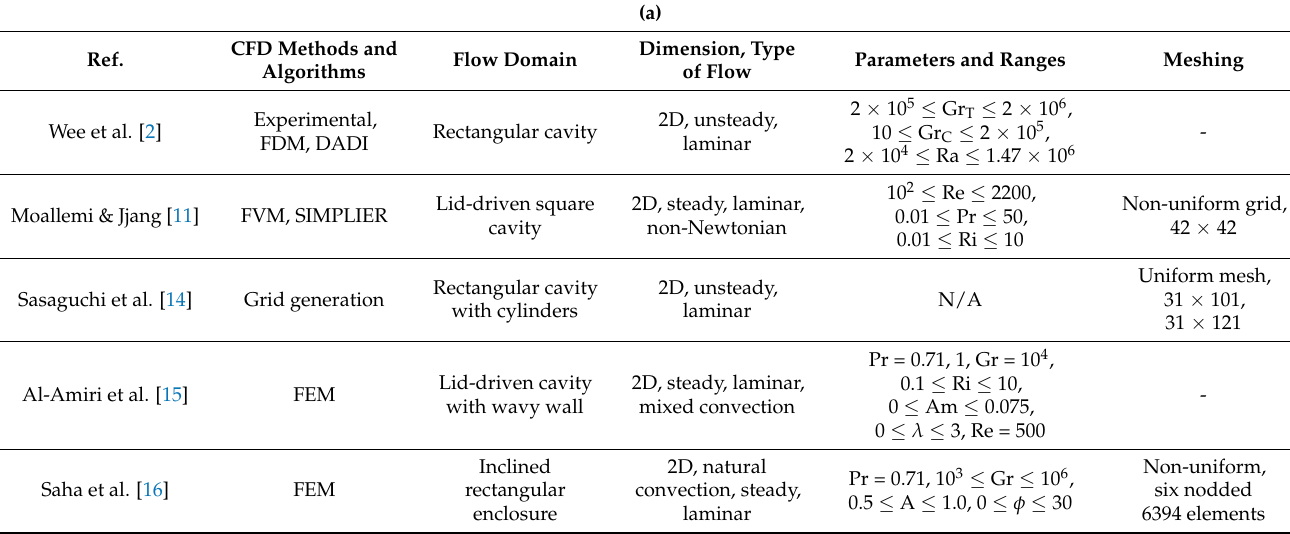
Table 1. (a): Research performed from 1989 to 2013. (b) The research was performed from 2014 to 2019. (c): Research performed from 2020 to 2023. (a)